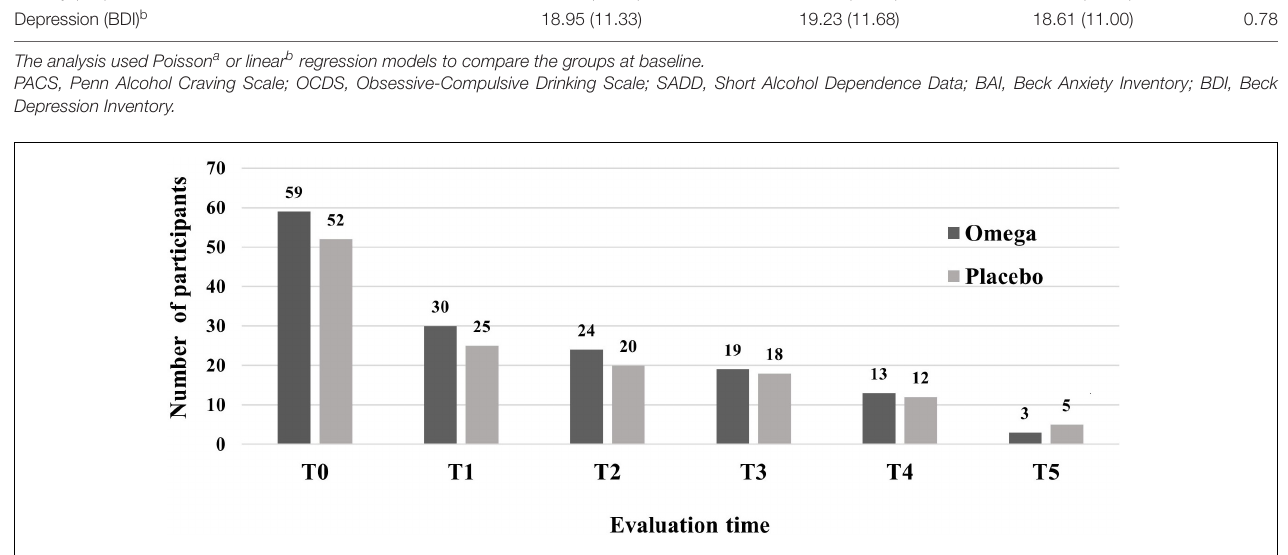
FIGURE 2 | Adherence of participants to interventions in the omega-3 and placebo groups. During hospitalization: T0 = screening, T1 = 1 month, T2 = 2 months, T3 = 3 months; Follow-up after starting treatment: T4 = 6 months. The number of participants in each evaluation is shown in absolute numbers above each bar.